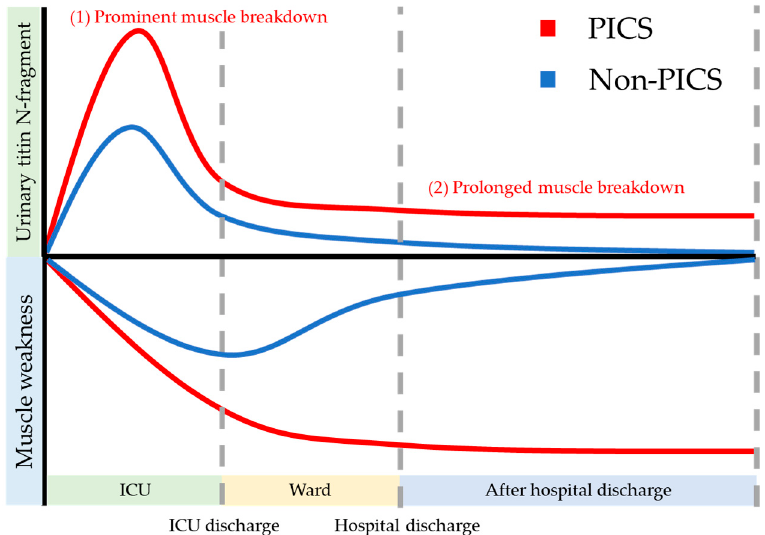
Figure 2. This is a conceptual image of urinary titin N-fragment and muscle weakness in PICS. In PICS, urinary titin N-fragment may be elevated due to the prominent muscle breakdown in the acute phase or prolonged muscle breakdown in the chronic phase, leading to the muscle weakness after hospital discharge. PICS: post-intensive care syndrome.